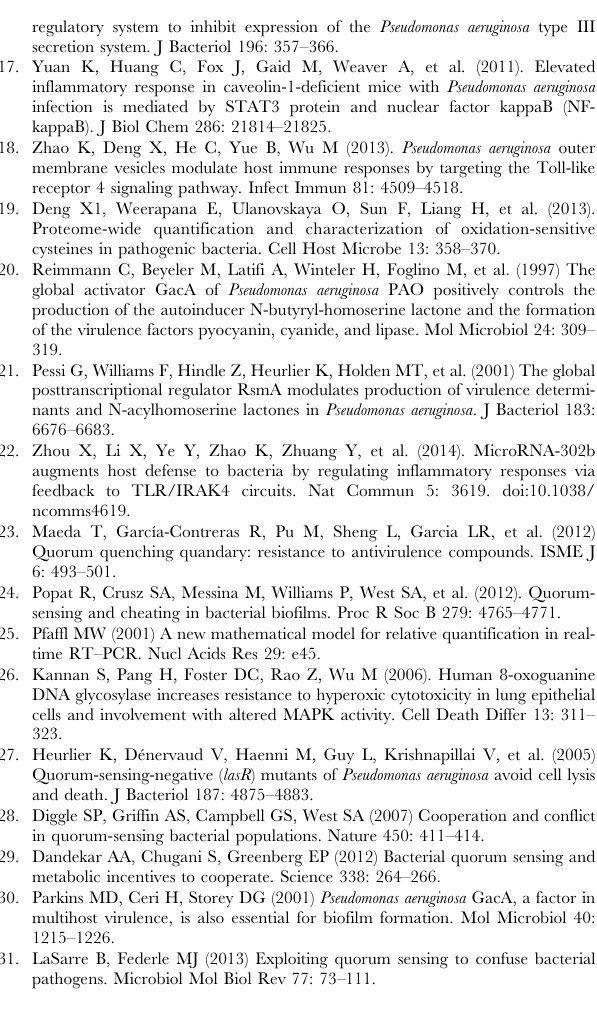
Figure S1 Colony forming units of different P. aerugi- nosa mutants in LB broth medium. All the data are represented as means 6 SEM, three replicates per culture. *, P , 0.001, one-way ANOVA (Tukey-Kramer post hoc). (TIF) Figure S2 Time-dependent expression of QS-related genes of different P. aeruginosa mutants in LB broth medium. Relative expression of main QS related genes in gacA mutant (A), rsmY mutant (B), rsmY mutant (C), rsmY and rsmZ double mutant (D), and rsmA mutant (E). All the data are represented as means 6 SEM, three replicates per culture. *, P , 0.05, **, P , 0.01, one-way ANOVA (Tukey-Kramer post hoc). (TIF) Figure S3 Colony forming units of different P. aerugi- nosa mutants in M9 minimal growth medium contain-